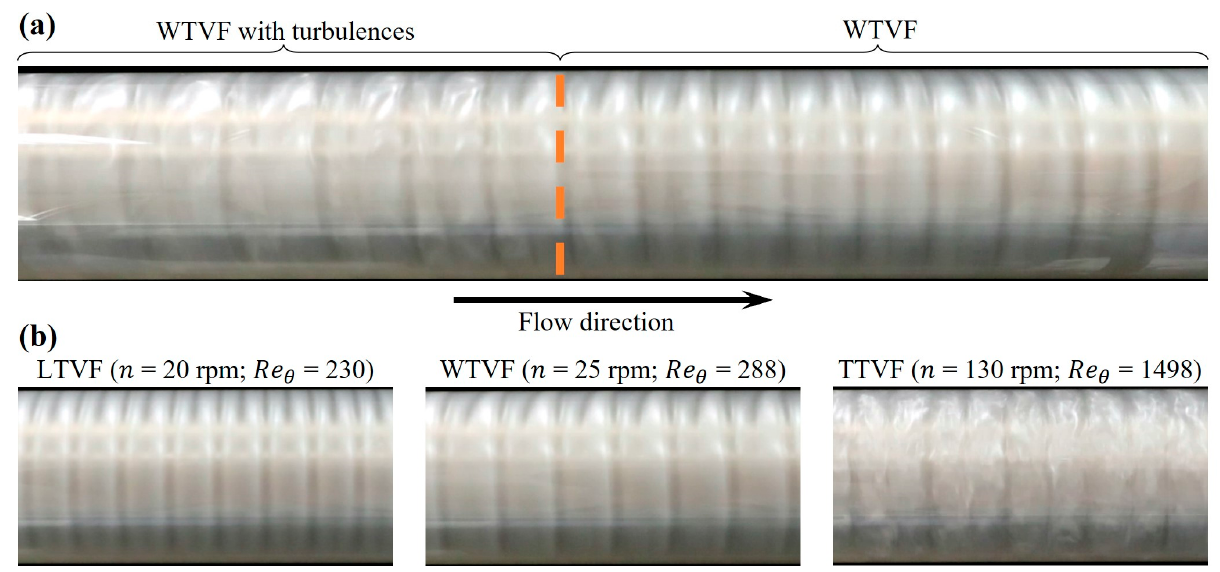
Figure 3. Photographs of the flow visualization experiments for w solid , Mica = 0.05 wt.%, η = 0.7, V = 92 mL · min and Re ax = 15.67. ( a ) Adjustment of the flow regime after a change in rotation rate from n = 25 rpm to n = 80 rpm. Existing wavy vortices retained their pattern and were displaced by newly forming turbulent wavy vortices. ( b ) Observed flow regimes; LCF is not shown. The cor‑ responding videos are supplied in the Supplementary Materials as ( a ) S1 and ( b ) S2–S4.